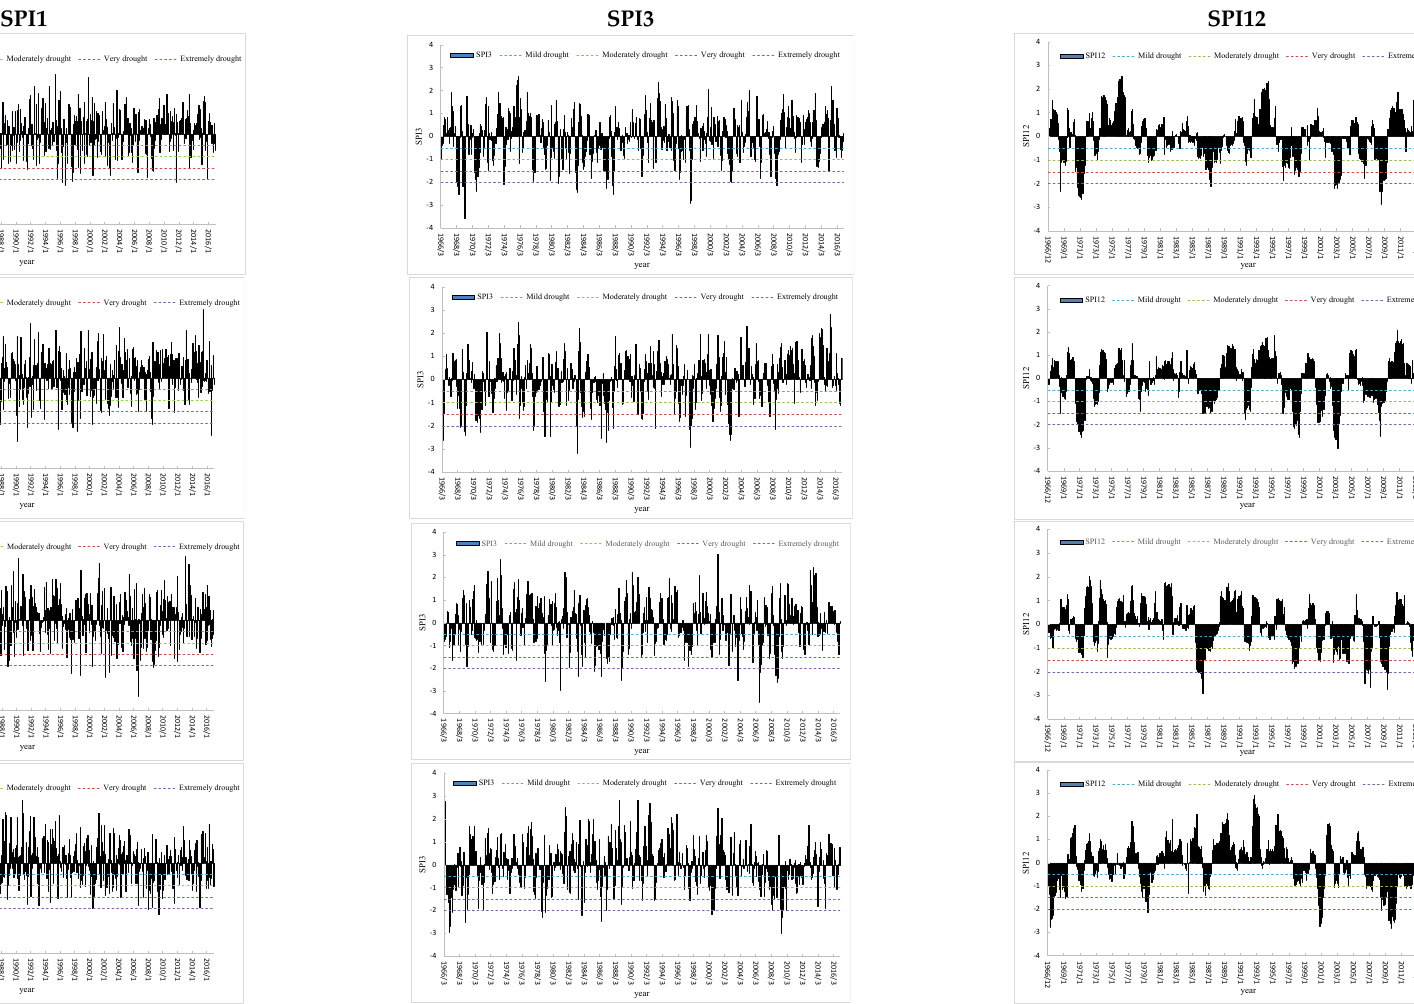
Figure 3. SPI1, SPI3, and SPI12 sequences in four regions.